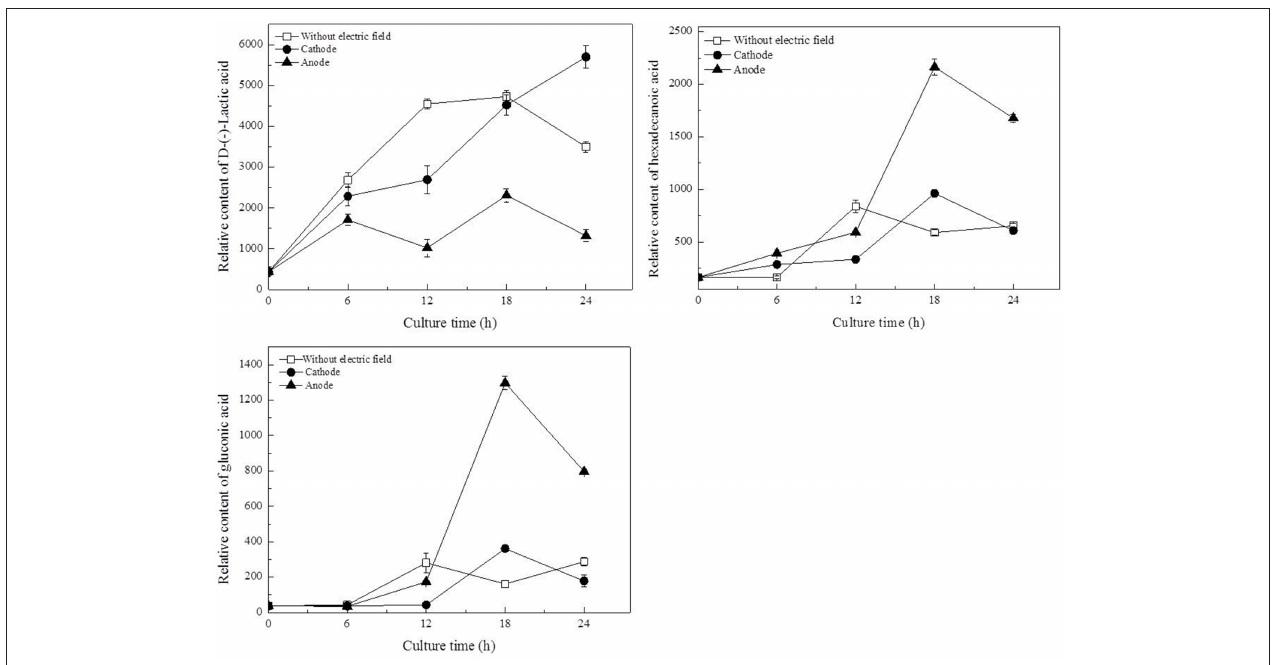
FIGURE 5 | Potential biomarkers for discrimination of samples from the control and DC treated groups. Data represent means ± SD from four independent experiments.